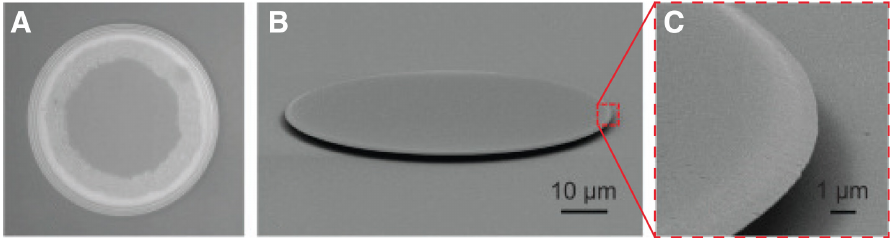
Figure 10: Microscope images of a typical LNOI microdisk resonator. (A) Optical microscope image of the microdisk from the top. (B) scanning electron microscope image showing the overview and (C) the edge of the microdisk. Reprinted with permission from Wang et al. [51]. © The Optical